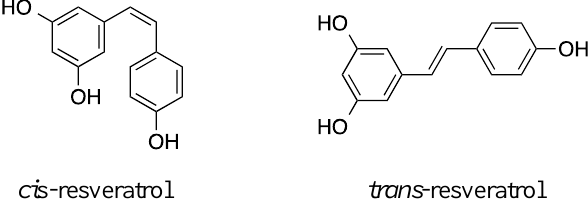
Figure 1. Isomers of resveratrol. Trans-resveratrol is more stable than cis-resveratrol and accounts for the beneficial effects of the polyphenol. Table 1. Structures, common sources and water solubility of polyphenols in this review.